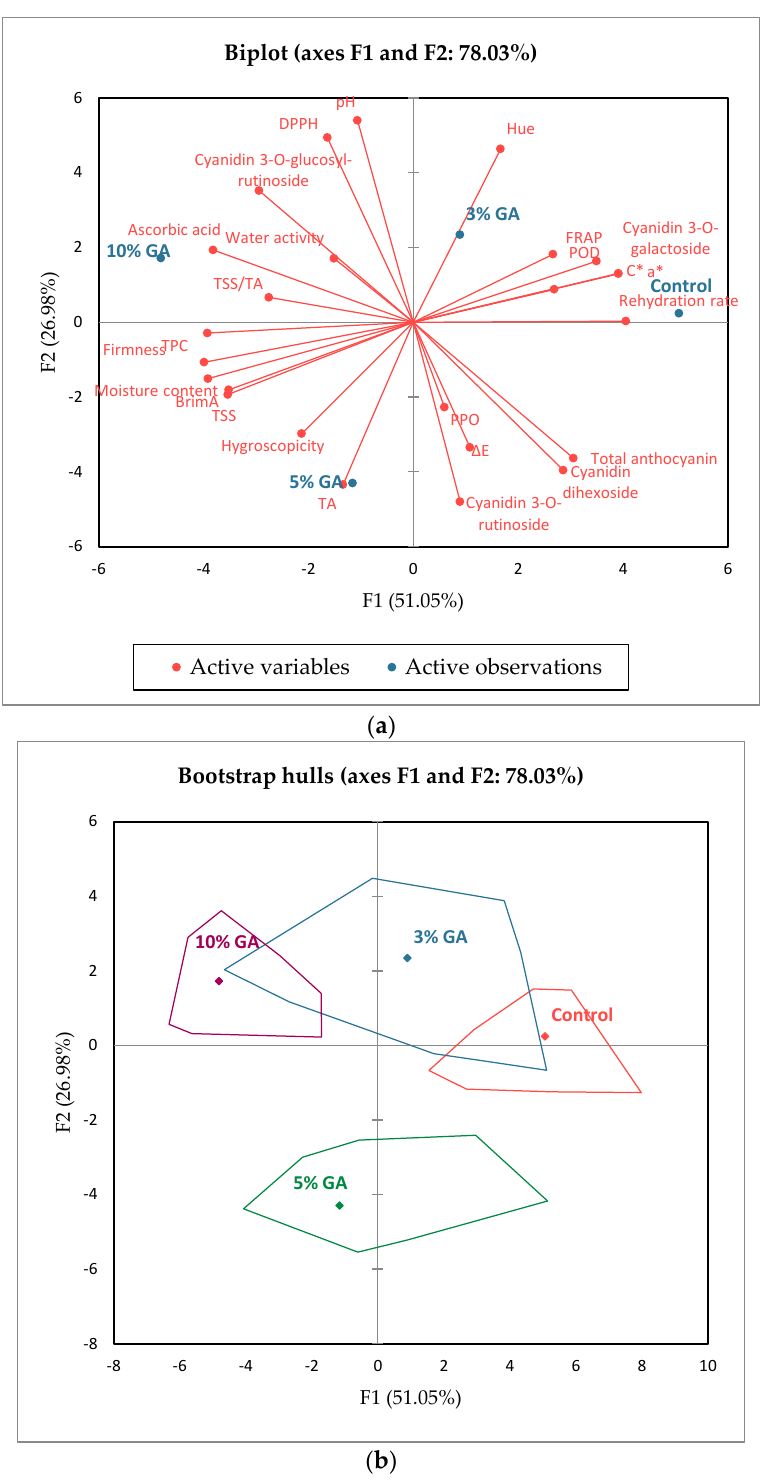
Figure 6. ( a ) Principal component analysis (PCA) biplot and ( b ) principal component analysis (PCA) bootstrap hulls showing the relationship between the quality attributes (active variables) and the pretreatments (control, 3%, 5% and 10%) (active observations) and confidence areas of oven-dried (60 ◦ C for 18–24 h) raspberries, respectively. DPPH = 2,2-diphenyl-1-picrylhydrazyl, TSS = total soluble solids, TA = titratable acidity, TPC = total phenolic content, PPO = polyphenol oxidase, POD = peroxidase, FRAP = ferric reducing antioxidant power, C = chroma, a = redness/greenness, ∆ E = total colour difference, GA = gum arabic. Control samples were dipped in distilled water for 2 min.